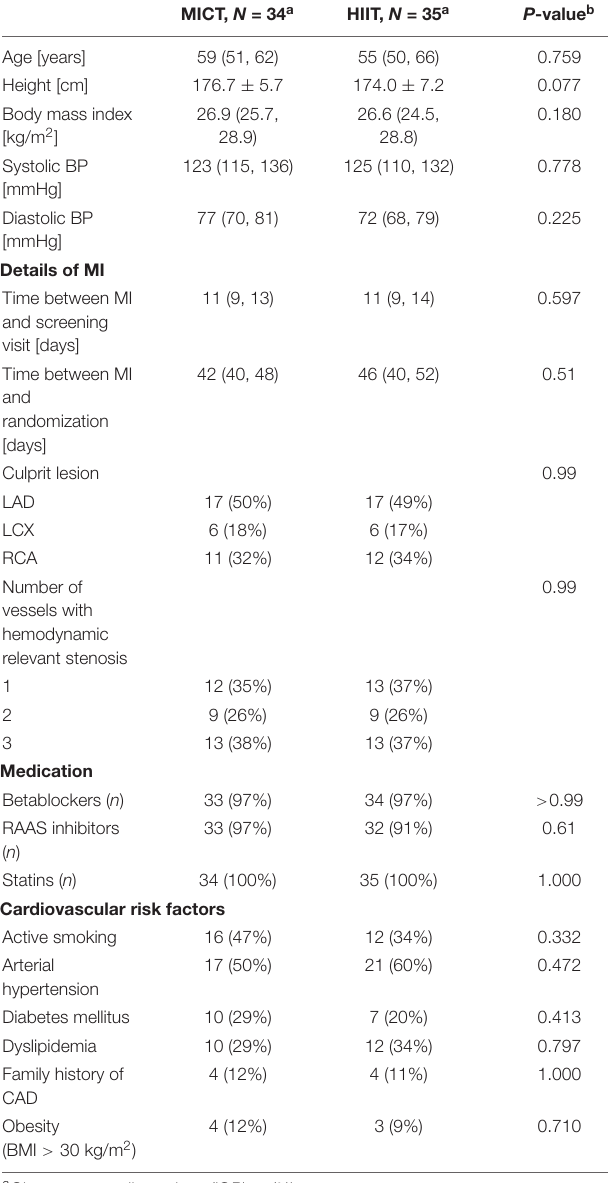
TABLE 1 | Patient characteristics at